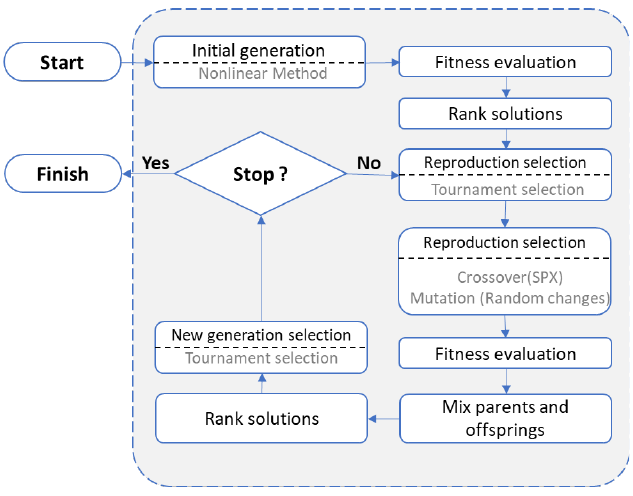
Figure 5. The characterization of GA computation in the research.